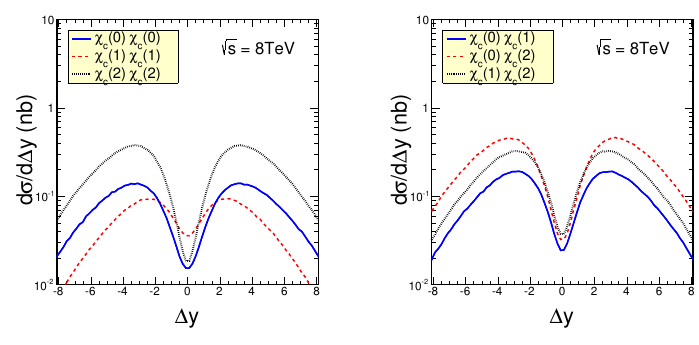
Figure 6. The distribution in rapidity di ff erence between χ c -mesons for all possible contributions of χ c ’s for the SPS mechanism.